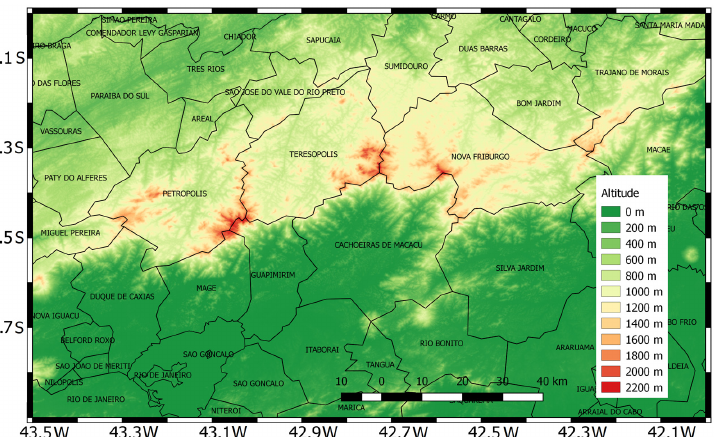
Figure 1. Extreme rainfall event study area in the municipalities of Nova Friburgo, Petrópolis, Teresópolis, Bom Jardim, São José do Vale do Rio Preto, Sumidouro, and Areal. Distance scales, latitude and longitude are indicated on the map. Color scale indicates altitude (m) from latitude 22° S to 22°48 ′ S and longitude 42° W to 43°30 ′ W. When studying the geotechnical maps of susceptibility to gravitational mass move- ments and fl oods of these seven municipalities [5], it can be seen that the altitudes vary from 40 m to 2220 m, and in the central municipalities of the region (Petrópolis, Teresópo- lis, and Nova Friburgo) that this variation is more accentuated, as shown in Table 1; the slopes vary from 0° to more than 45°, whereas in Petrópolis, Teresópolis and Nova Fri- burgo slopes greater than 20° predominate. Table 1. Geomorphological characteristics of the municipalities of the mountainous region of Rio de Janeiro State (Figure 1). Municipality